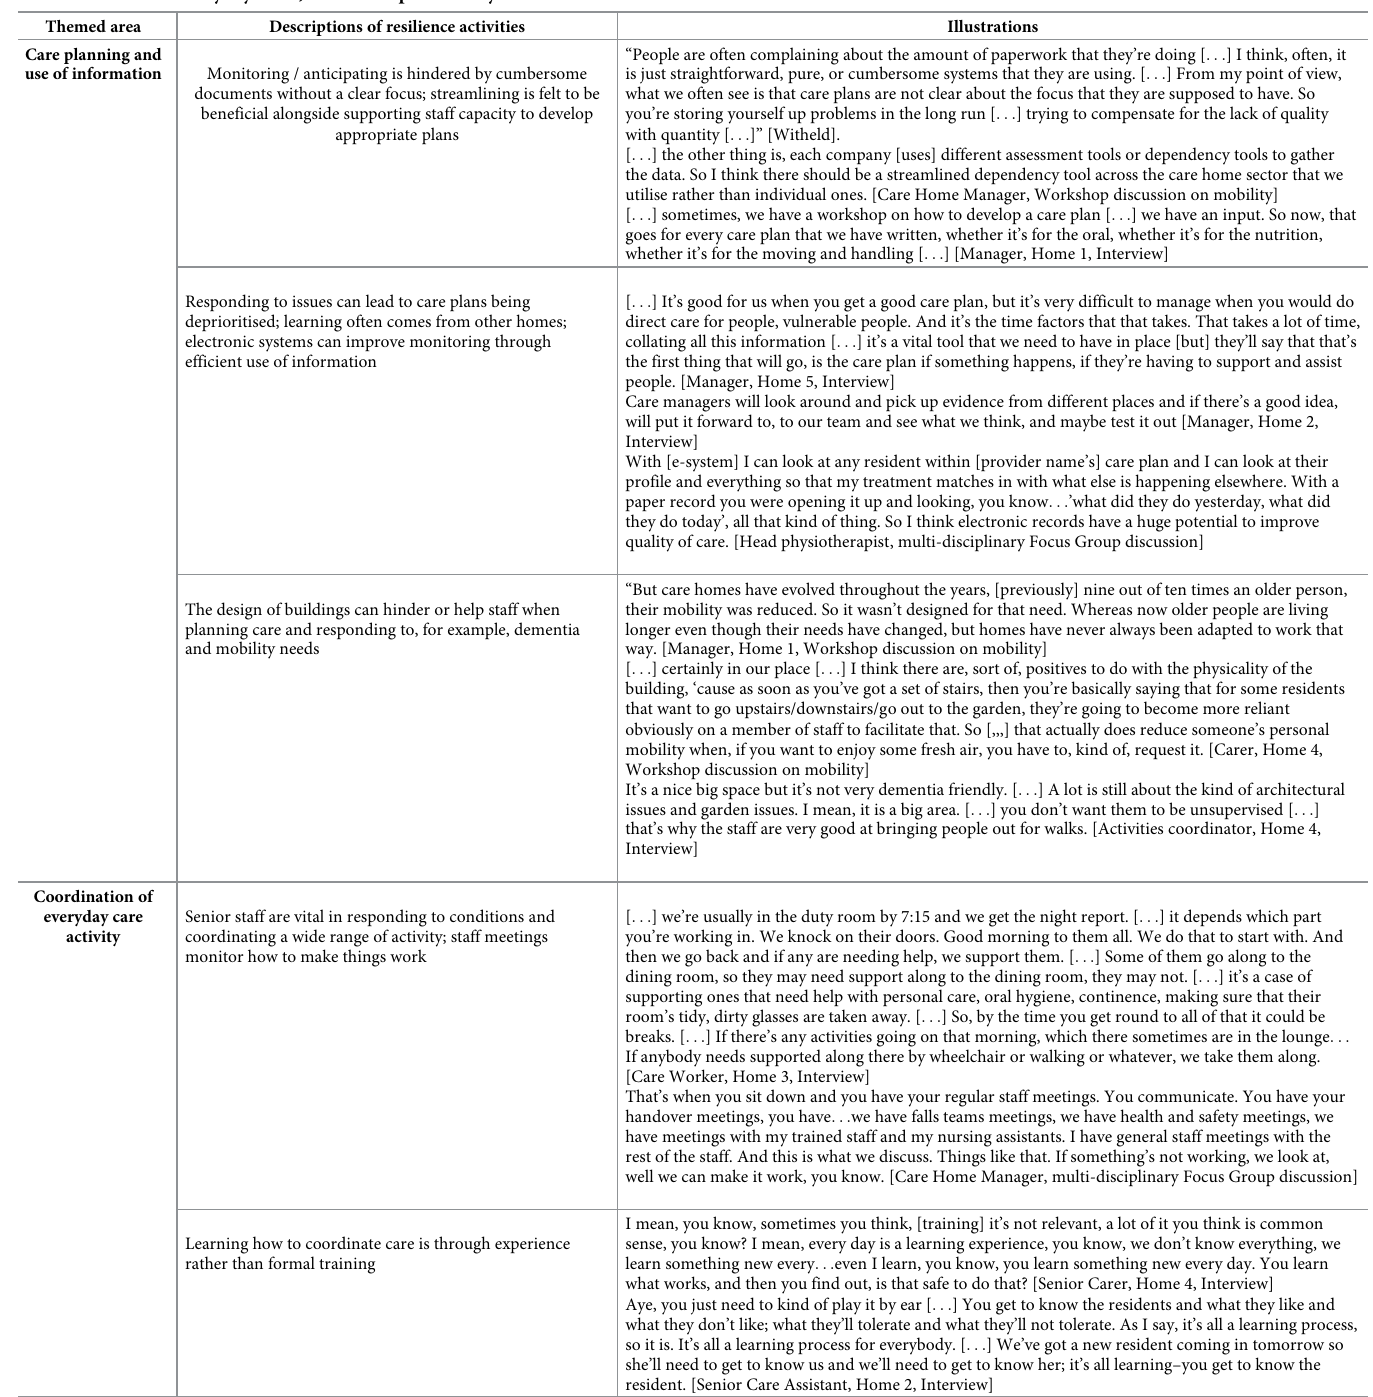
Table 3. Themes in everyday work, with description of key resilience activities. Themed